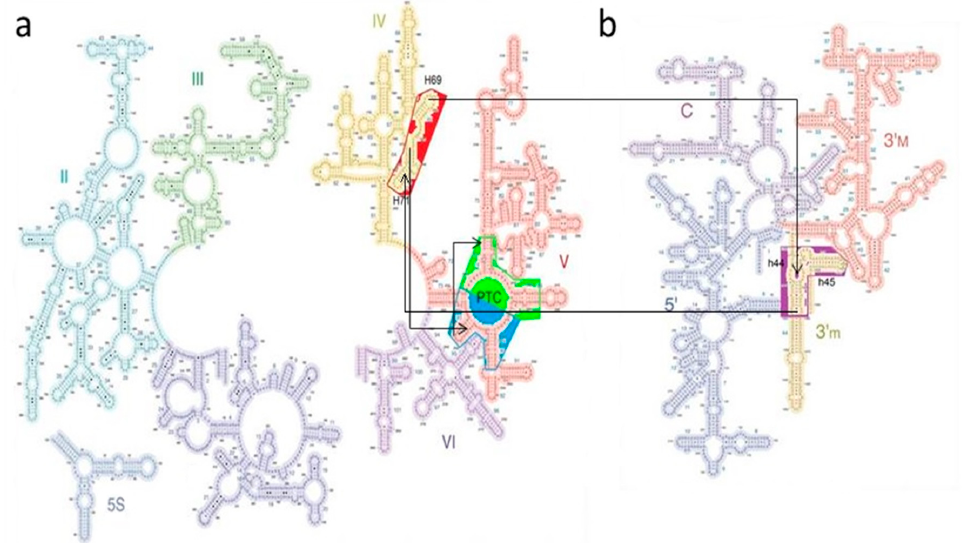
Figure 4. Building blocks of the suggested coded proto-ribosome, depicted on a secondary scheme of the LSU ( a ) and SSU ( b ). The symmetry-related A-DPR (blue background) and P-DPR (green background) monomers, together with the H69–71 bridging element (dark red background), form the suggested proto-LSU, and h44–45 (purple background) forms the proto-SSU. Nucleotides and base-pairs involved in A-minor interactions are connected by